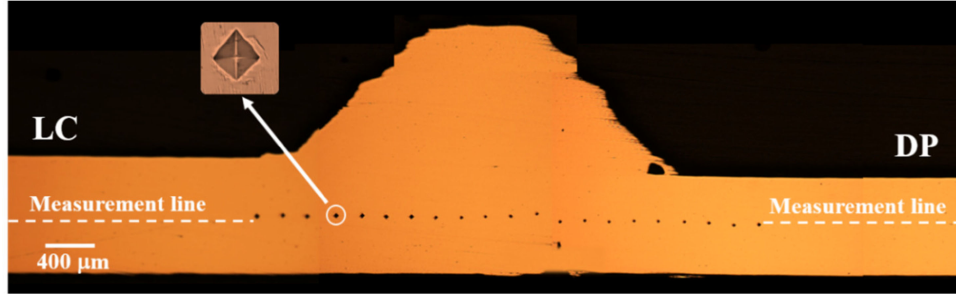
Figure 3. Welded joint and indentation line followed for the microhardness